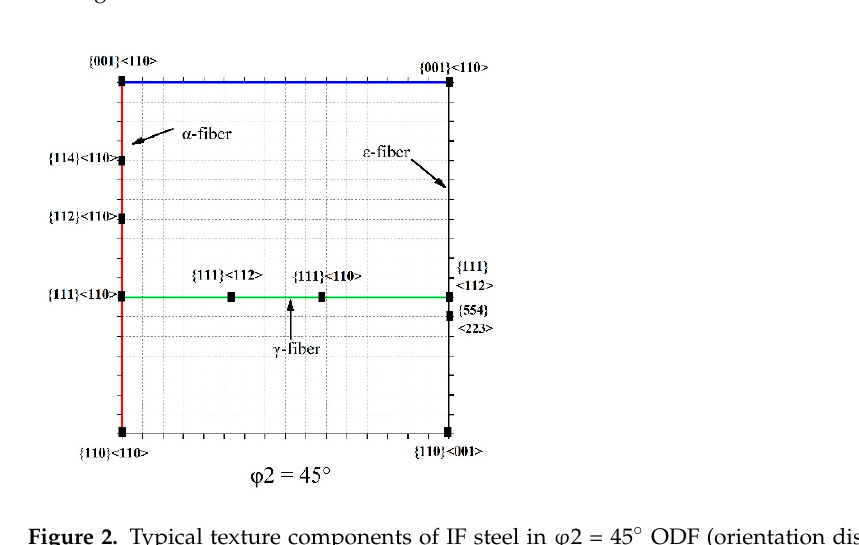
Figure 1. Sample geometry for EBSD (electron backscatter diffraction) and XRD (X-ray diffraction) investigation.